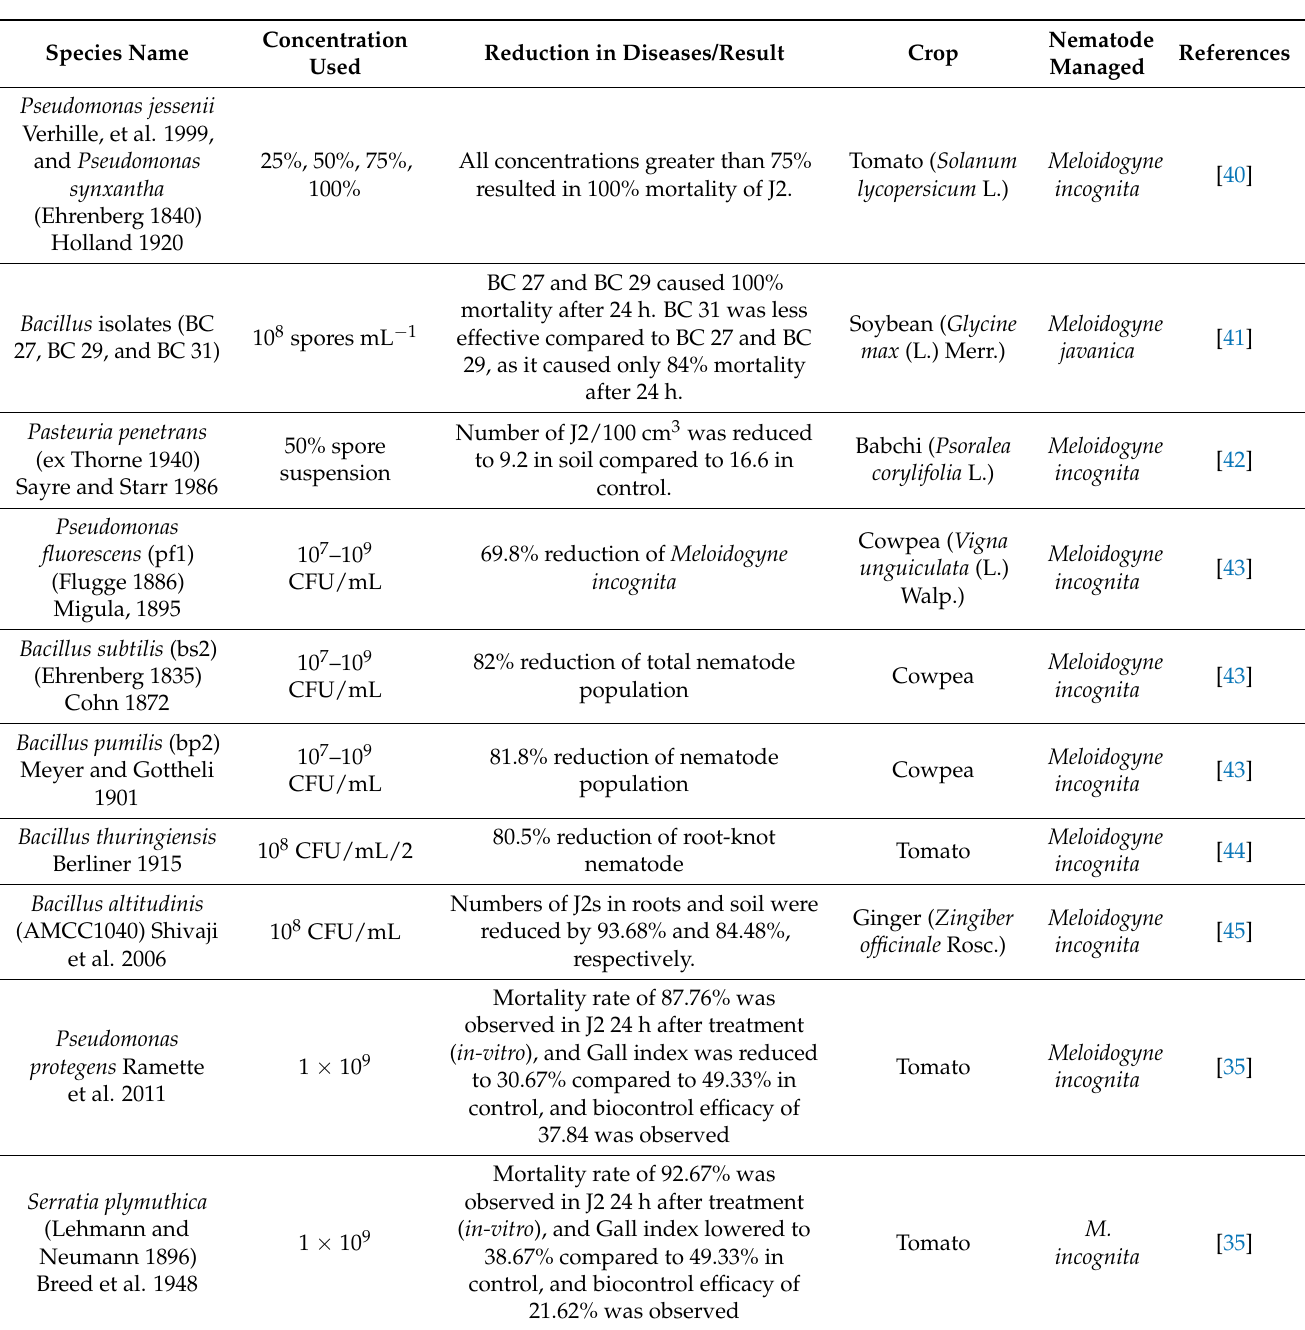
Table 1. Bacterial species as antagonists against root-knot